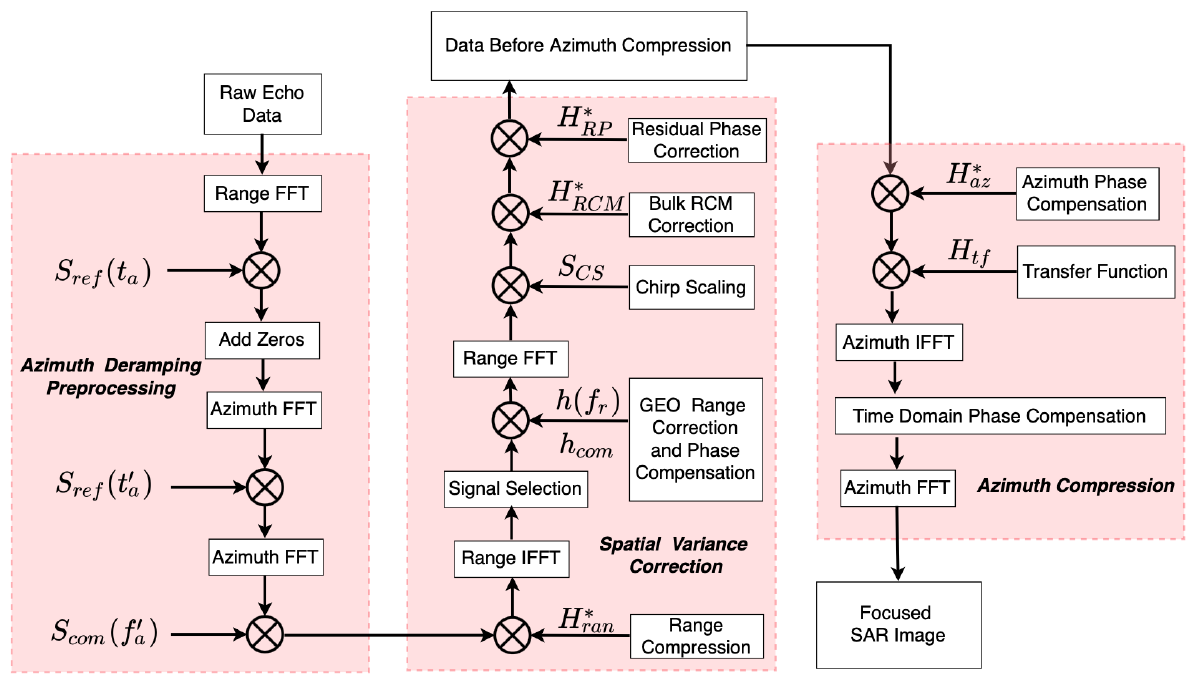
Figure 9. The flow-process diagram of the entire